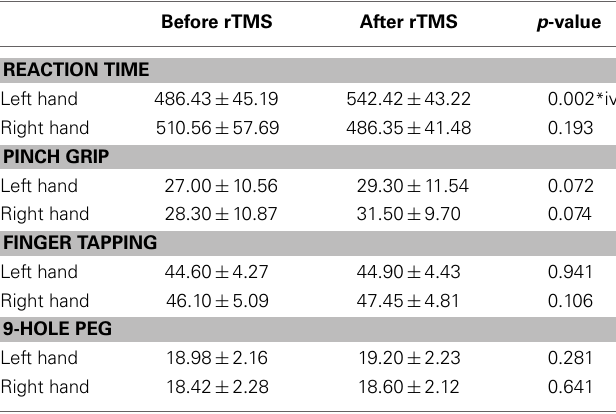
Table 4 | Pre- and Post-rRMS comparisons of behavioral data for older